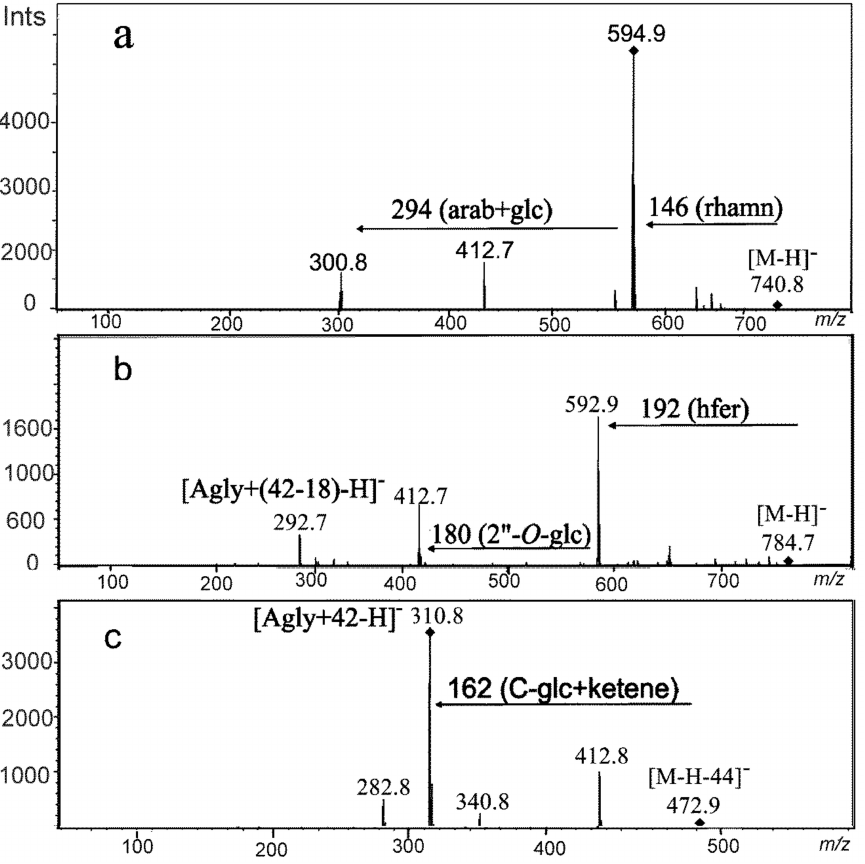
Figure 4. MS2 spectra in negative ionization of compounds ( a ) no. 117, quercetin O -rhamnoside- O -arabinosylglucoside; ( b ) no. 133, hydroxyferuloyl-isovitexin 2”- O -glucoside; ( c ) no. 152, isoitexin malonylated. (Agly-aglycon, glc-glucoside, rhamn-rhamnoside, hfer-hydroxyferulic